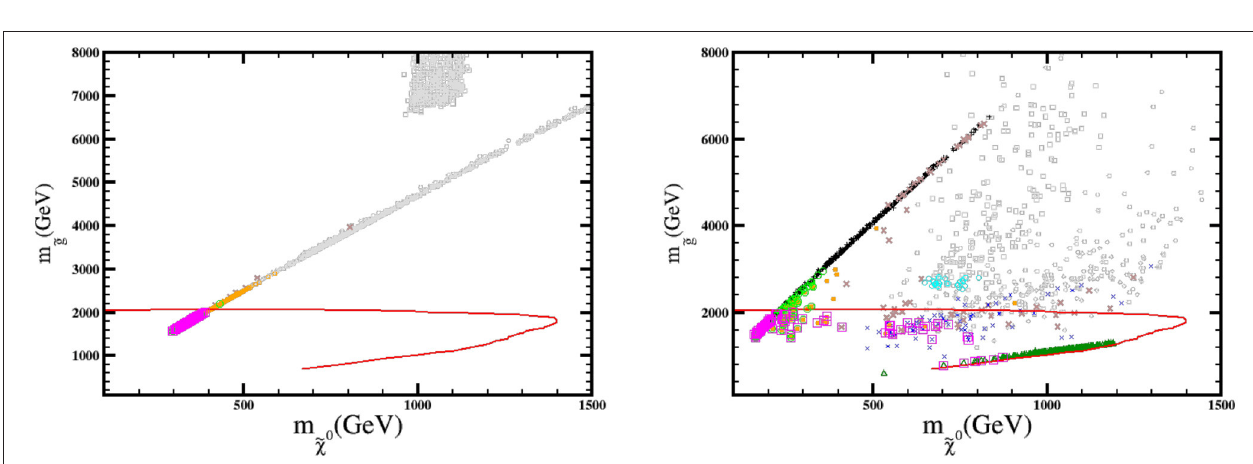
g vs. m χ scatter ˜